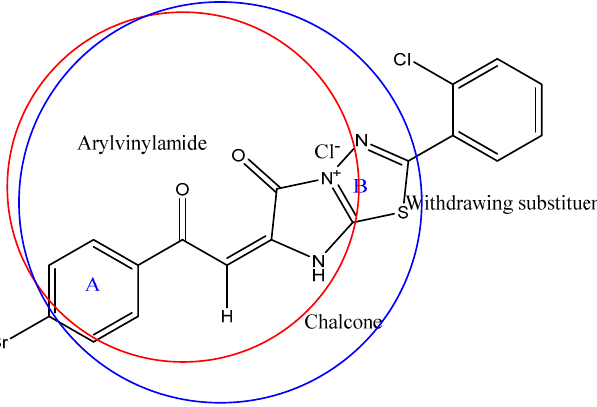
Figure 2. Outlines the ring B in a blue circle that contains three electronegative nitrogen atoms, a carbonyl group and a halogen atom. These elements decrease the HOMO value and increase activity. Red circle outline aryl vinyl amide structure isostere for synthesized chalcones 4 .